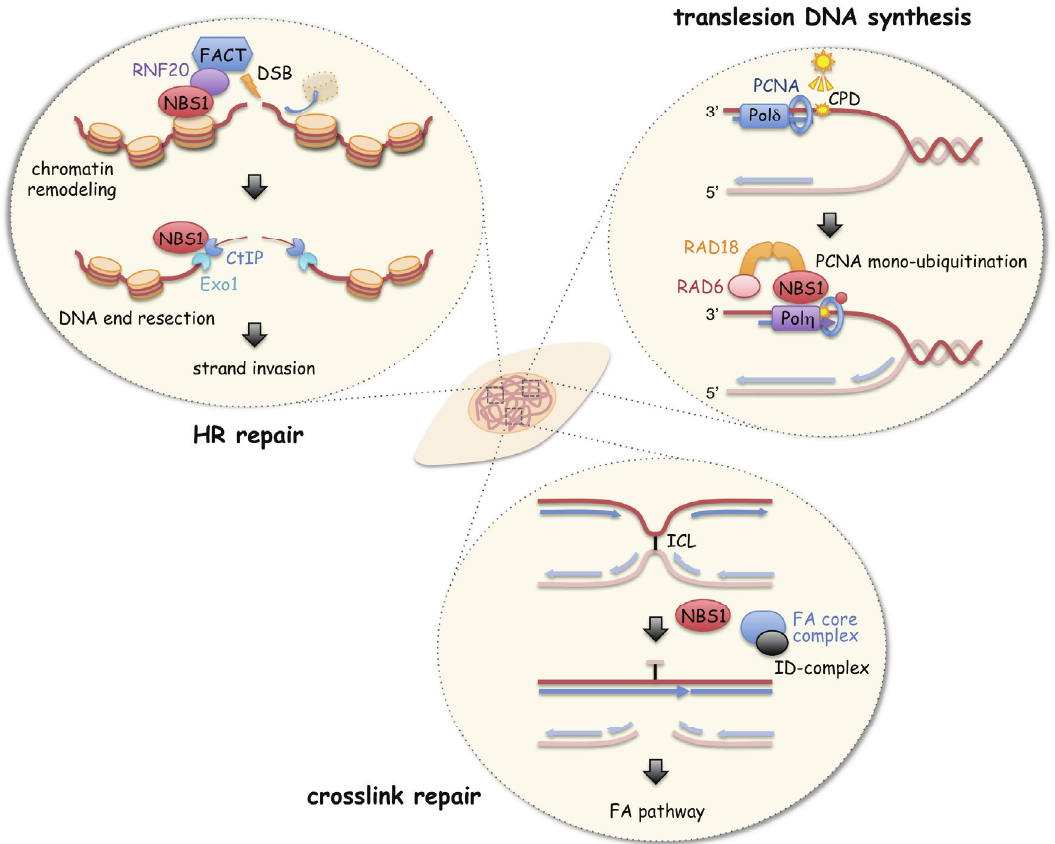
Figure 2. NBS1 acts as a coordinator to maintain the genome integrity. NBS1 cooperates with FACT on RNF20 recruitment and the initiation of HRR. For UV-induced damage, NBS1 interacts with RAD18 and promotes PCNA monoubiquitinaiton for TLS